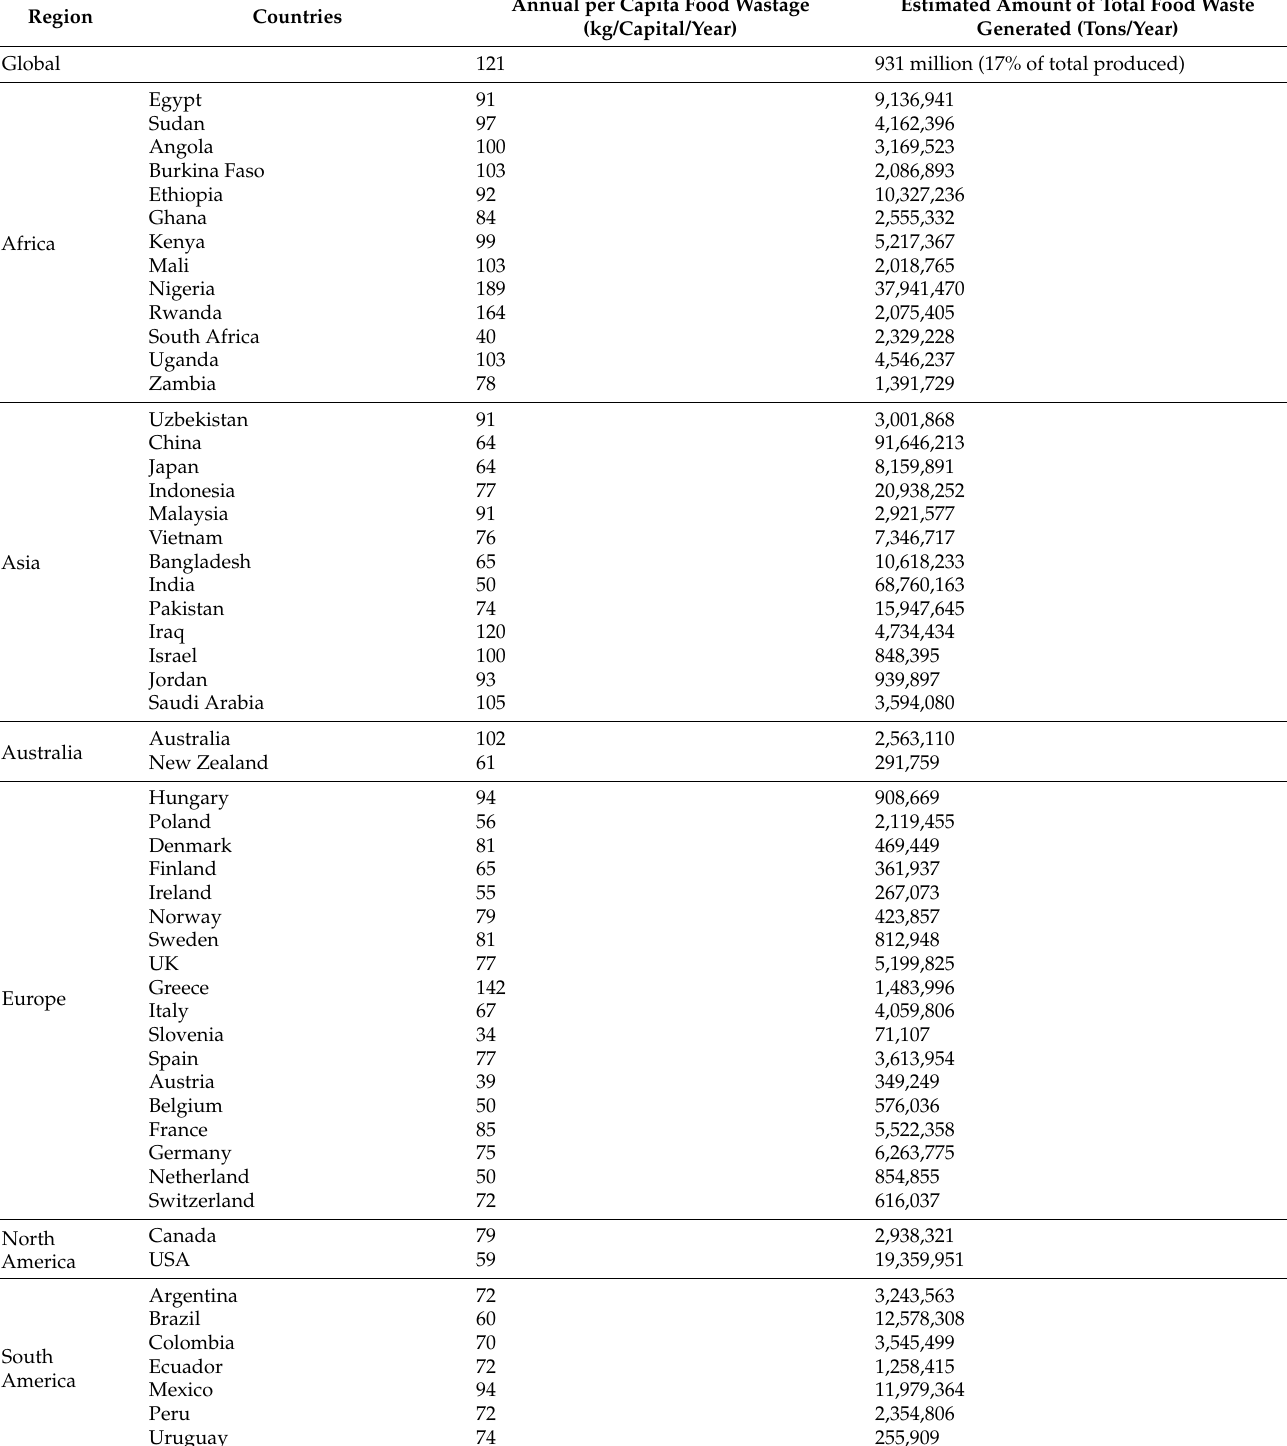
Table 1. Food waste estimates by countries across the globe in the year